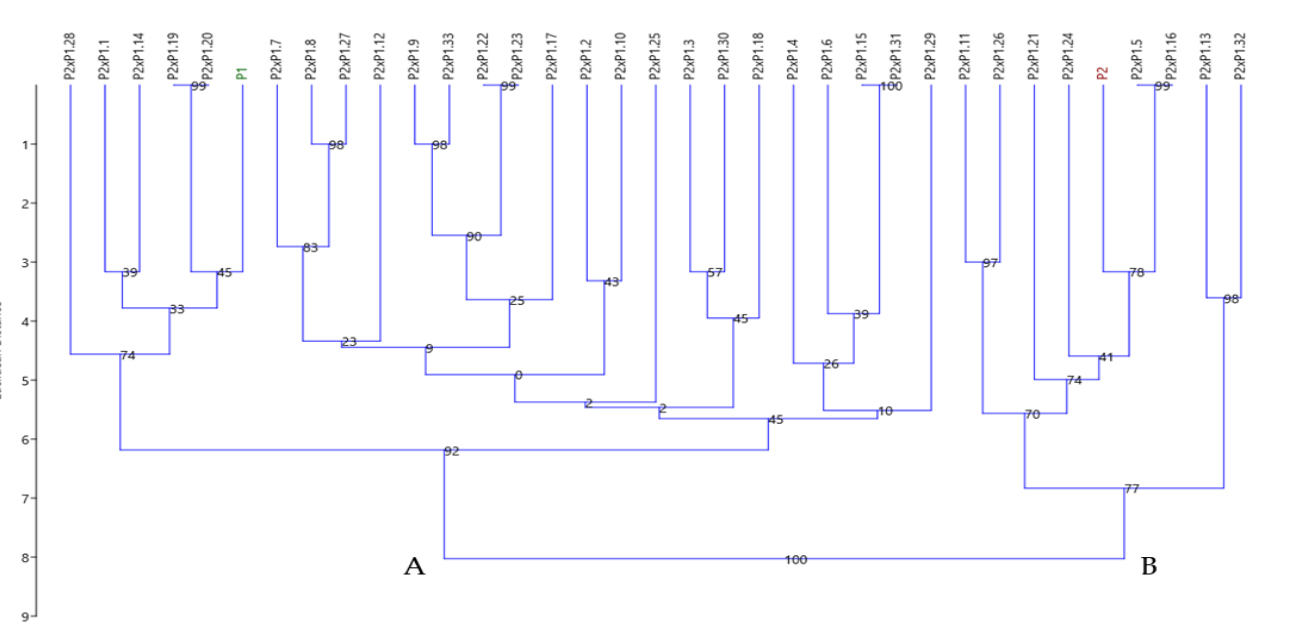
Figure 7. UPGMA dendrogram generated by SCoT markers, showing the relationships between parents (P1 and P2) and F 1 plants from P1×P2 cross and based on Euclidean’s distance index. Numbers on the branches show bootstrap values, computed from 10,000 replications. In dendrogram, the mother parent is marked with red color, while the father parent is marked with green color.